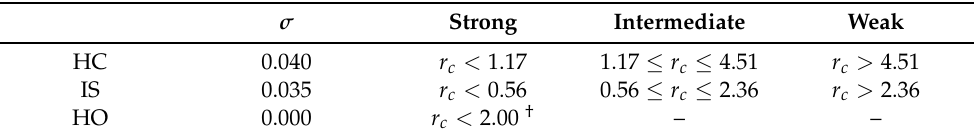
Table 1. Confinement regions for the hydrogen confined (HC), ion-sphere (IS), and confined harmonic oscillator (HO).